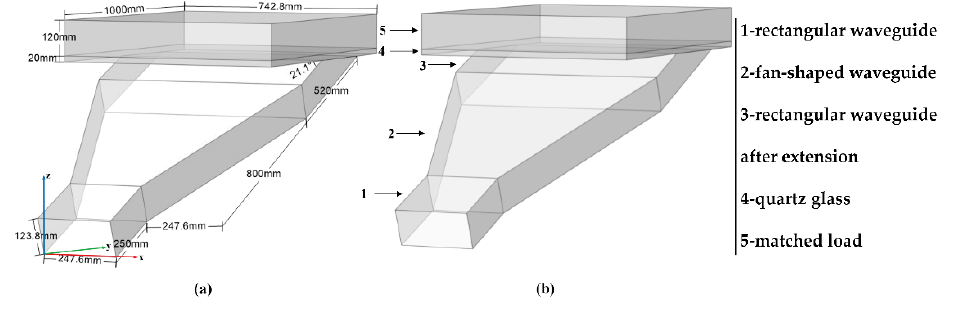
Figure 1. Geometrical model ( a ) and construction ( b ).